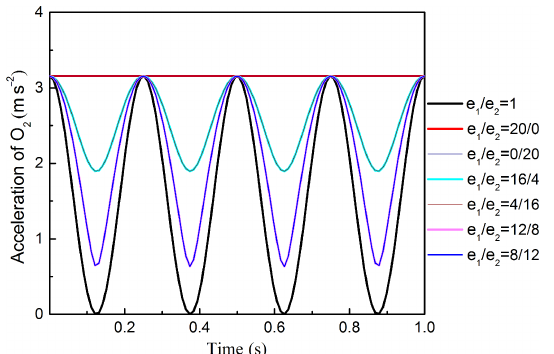
Figure 8. Effects of e 1 /e 2 on the acceleration when ω 1 = − ω 2 ( e 1 + e 2 = 2 e ).